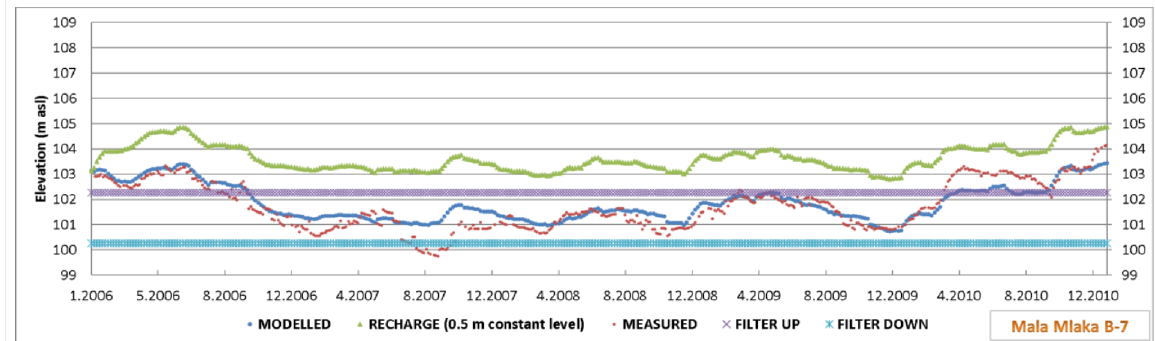
Figure 14. Influence of the MAR variant with a constant level of 0.5 m in the Sava-Odra Canal on well B-7 of the Mala Mlaka water pumping